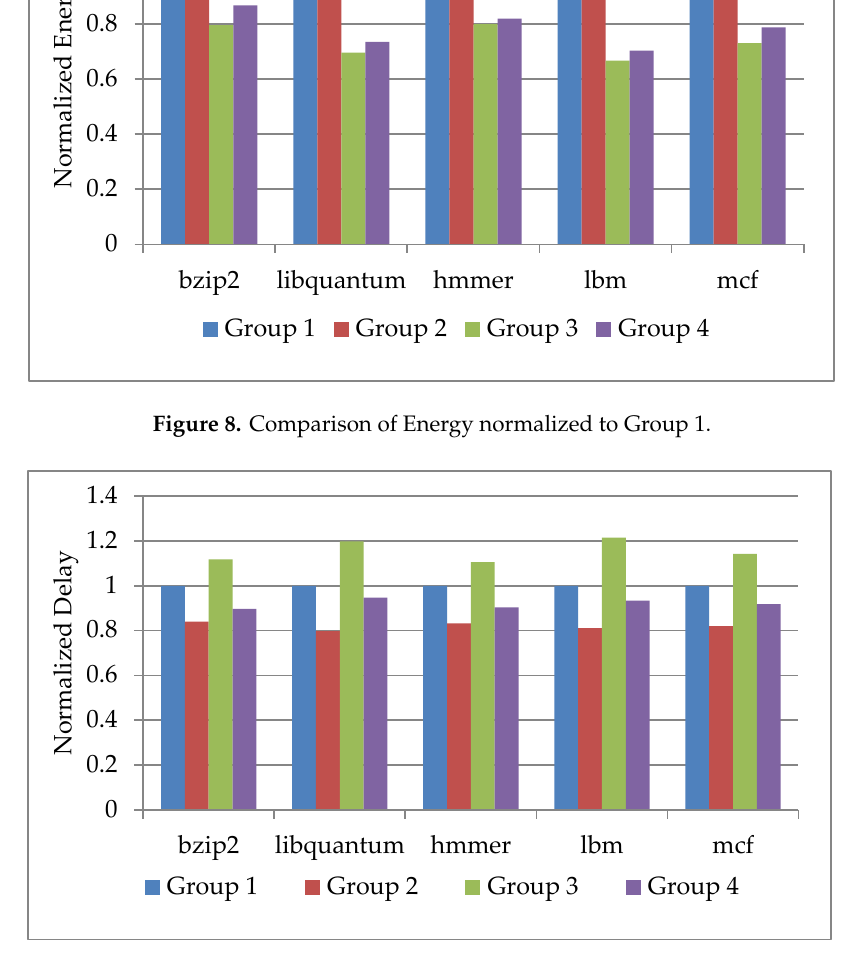
Figure 10. Comparison of Energy-Delay Product normalized to Group 1. Figure 11 shows the distribution of write operations to STT-RAM normalized to all write operations for different applications. It can be seen that the CFM reduces write operations to the STT-RAM portion to 32% on average of the total number of write operations. In libquantum and lbm